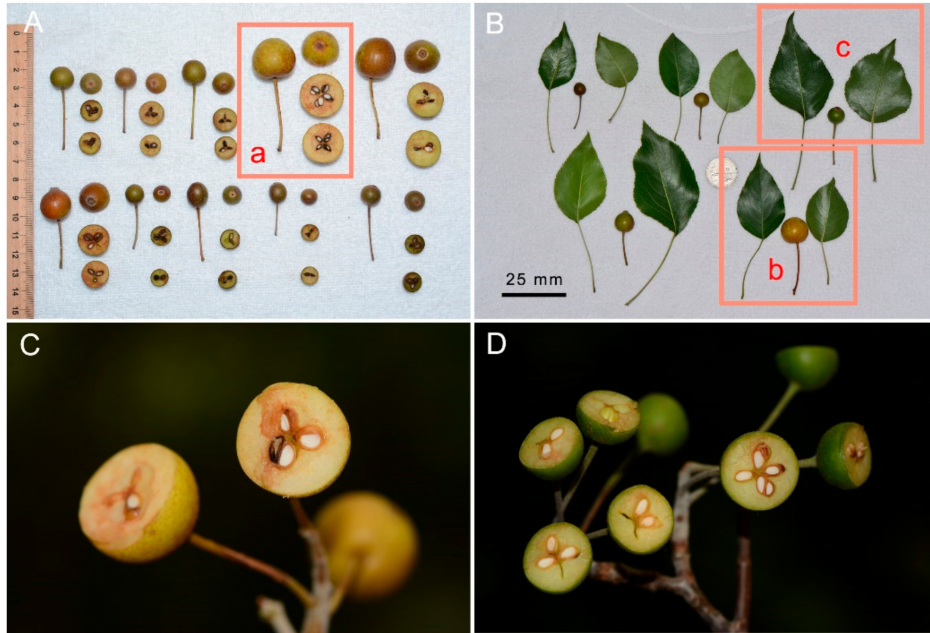
Figure 4. Fruits and leaves of Pyrus phaeocarpa and P. betulifolia from the type locality of P. hopeiensis , the Jieshi Mountain, Changli County, Hebei Province. ( A , B ) Fruits and leaves of P. phaeocarpa and P. betulifolia , ( C , D ) cross-cut of fruits of P. phaeocarpa and P. betulifolia , respectively, indicating 3–4 carpels per fruit. ( A ( a ), B ( b ), C ) were collected from the same tree of P. phaeocarpa , ( B ( c ), D ) were collected from the same tree of P. betulifolia